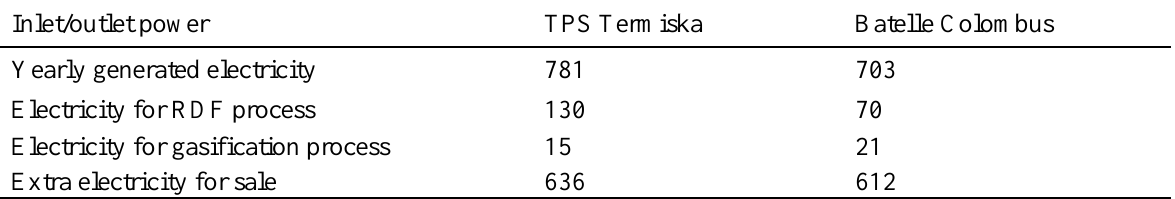
Table 3 . Outlet and inlet power of gasifiers